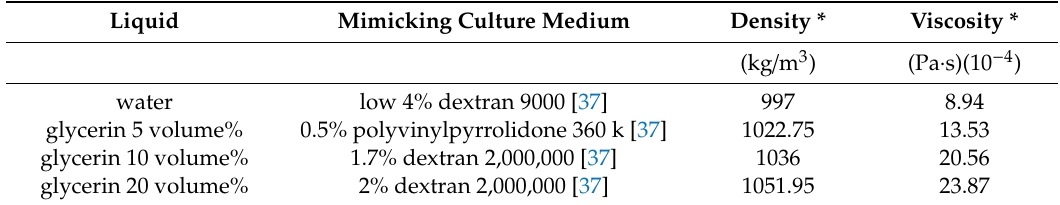
Figure 1. Schematic diagram of the experimental devices. Table 2. Characteristics of liquids.